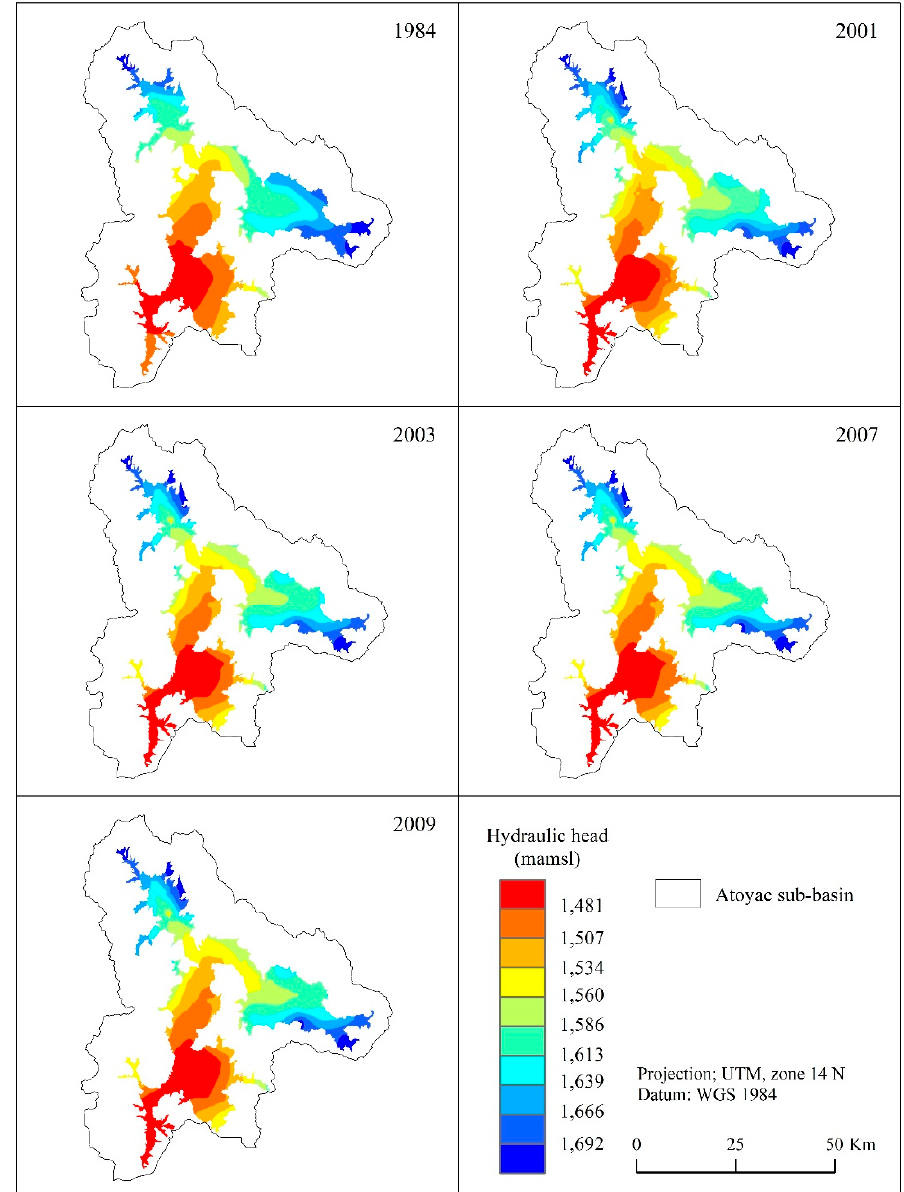
Figure 6. Piezometric head (in m) in the Central Valleys of Oaxaca during the dry seasons of 1984, 2001, 2003, 2007, and 2009